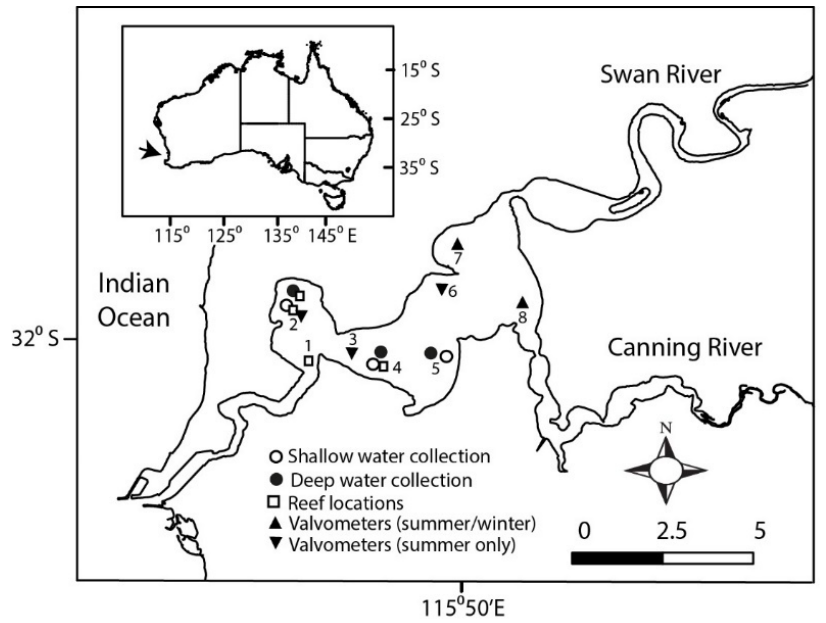
Figure 1. Map of the Swan-Canning Estuary showing the locations of the Mytilus galloprovincialis reefs, valve gaping monitoring sites, and collection sites for estuary water used in feeding experiments. Insert in the map shows the location of the estuary in Australia. Sites numbered 1 to 8.